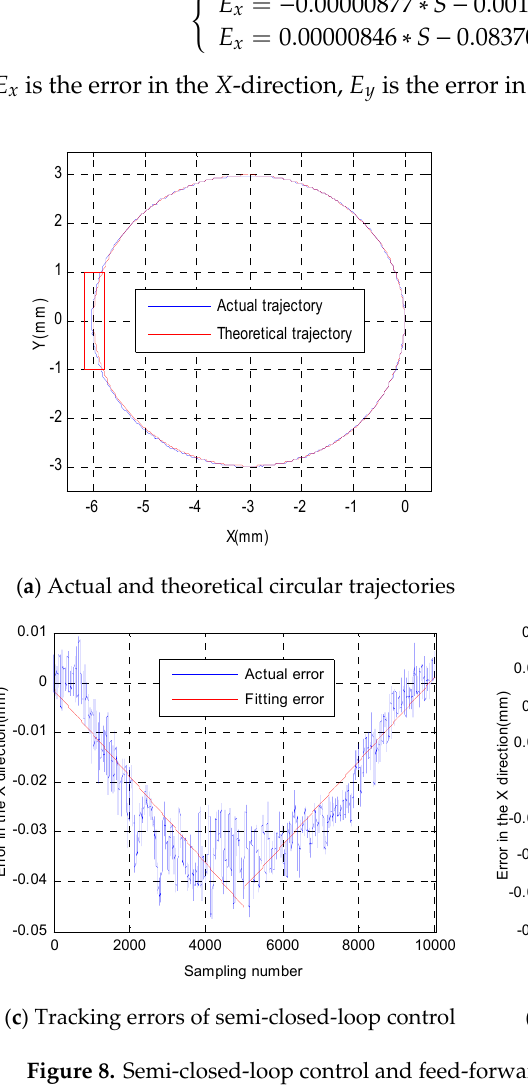
Figure 9. Schematic diagram of feed-forward control with the error fitting function.